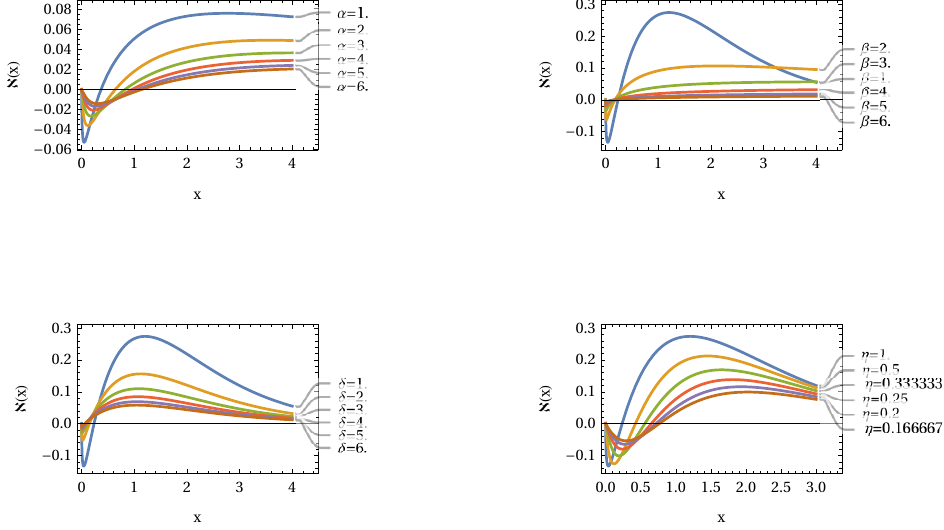
Figure 13. Variation of parameters (indicated in the panels) for A α ( s ) , A β ( s ) , A δ ( s ) , and A η ( s ) . Example 6. Two parameter weighted Mittag-Leffler (wML)